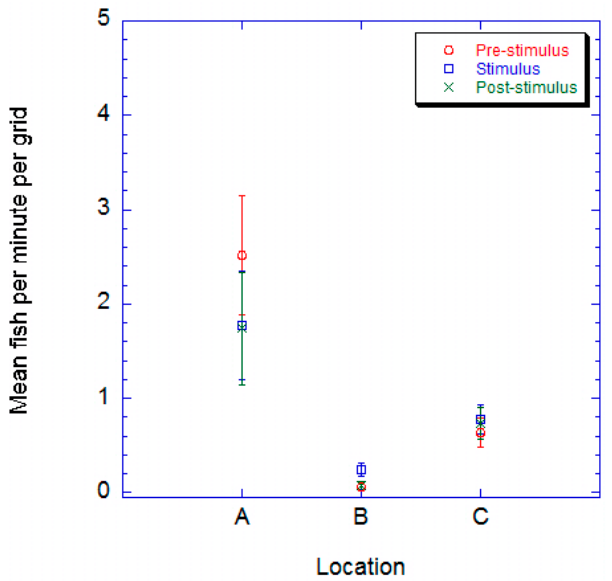
Figure 1. Mean ( ± SE) number of juvenile common carp per minute per grid (N = 15). Figure 1. Mean (±SE) number of juvenile common carp per minute per grid (N = 15).